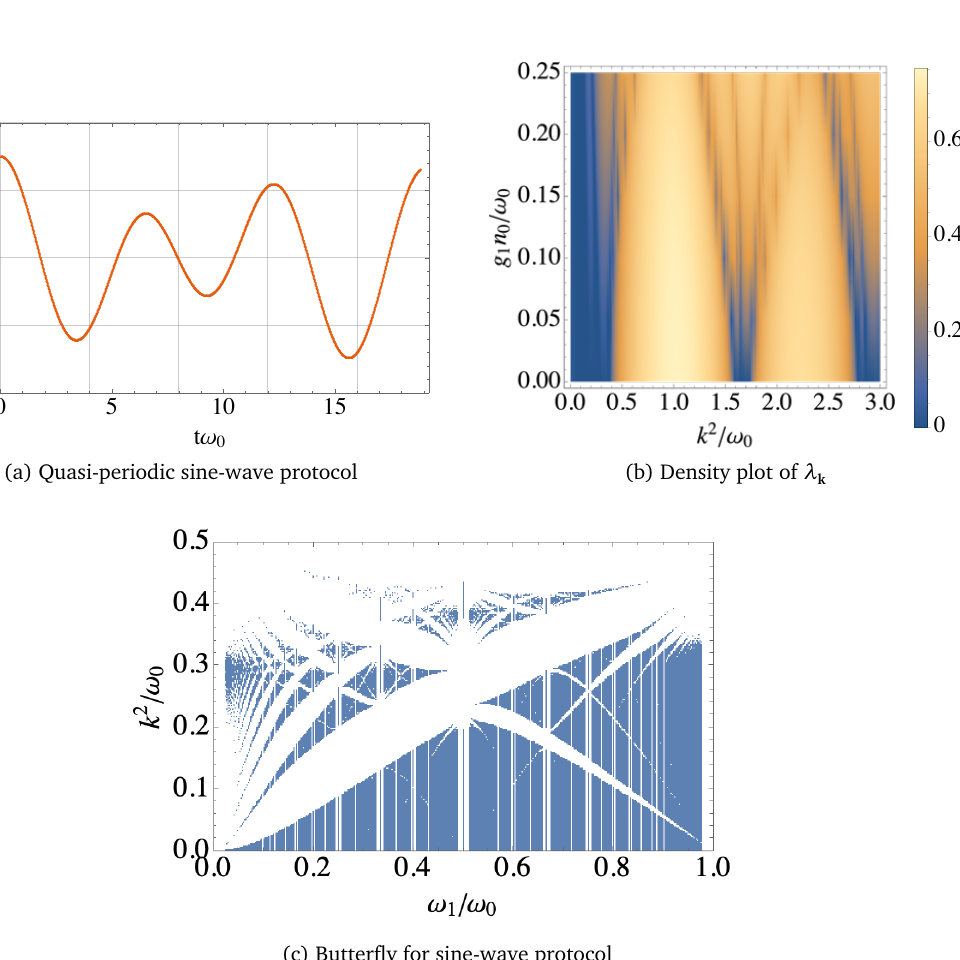
/ω = 0.5 n with g k 0 0 0 /ω = 0.5 and n 0 0 0